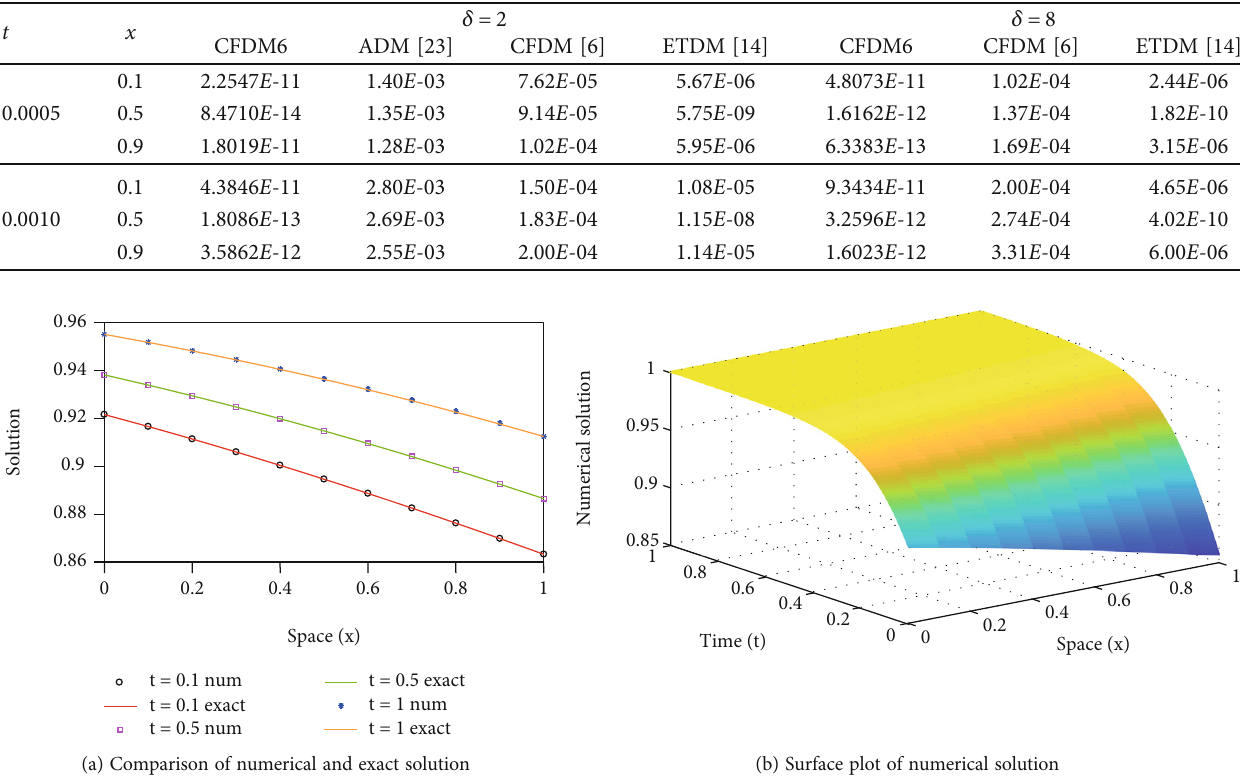
Figure 4: Graphical representation of solutions corresponding to Example 2 with N = 10 and Δ t = 0 : 001